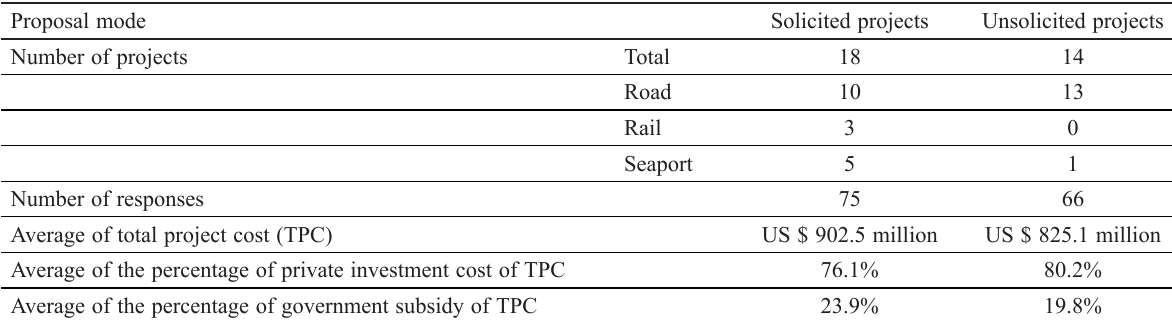
Table 1. Descriptive statistics of projects collected through